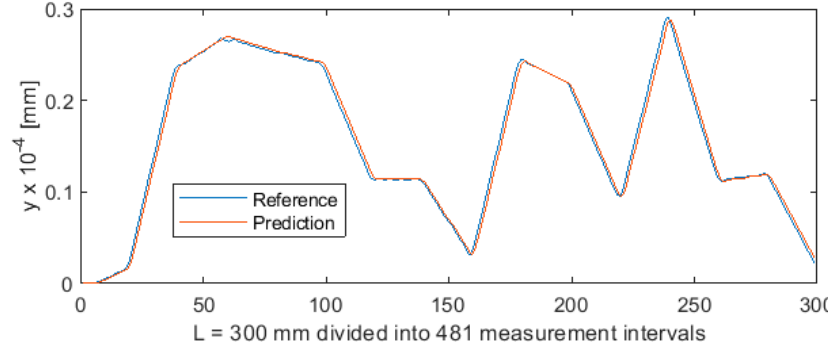
Figure 21. Machining quality prediction using NARX.